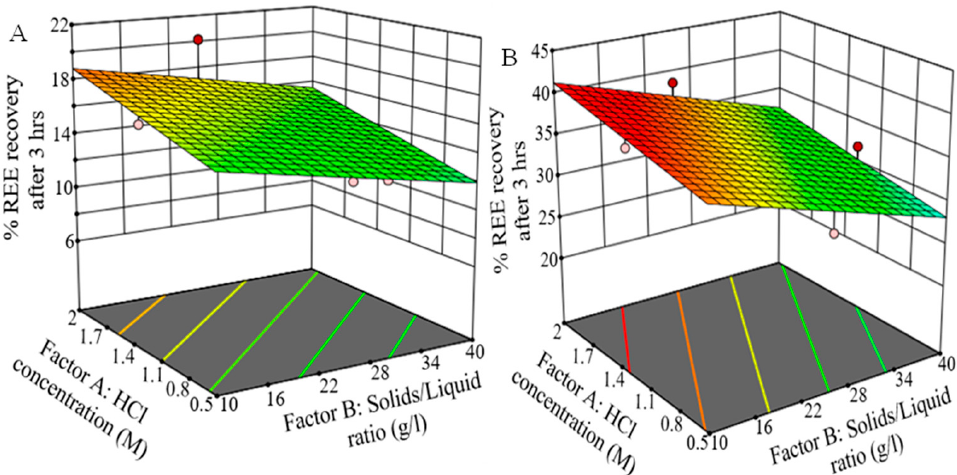
Figure 4. 3D surface plots of the relationship between leachate concentration, pulp density (solid: liquid ratio), and their impact on the % REE leaching recovery for RC1 ( A ) and DC1 ( B ).